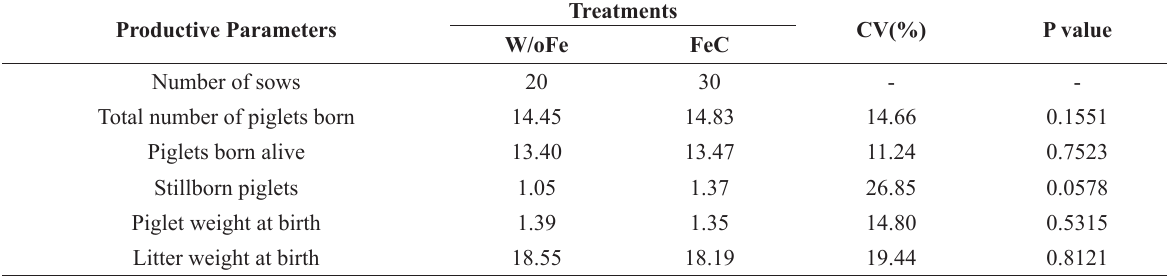
Reproductive parameters of sows fed diets with or without iron chelate supplementation at gestation phase. Productive